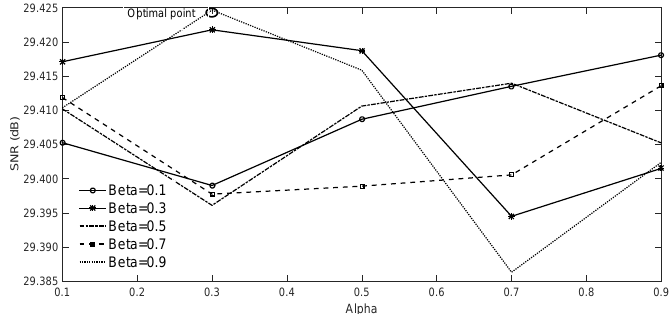
Figure 2. Signal to Noise Ratio Performance of the Spectral Unmixing Bayesian Sparse Algorithm Versus α and β on Pavia dataset.